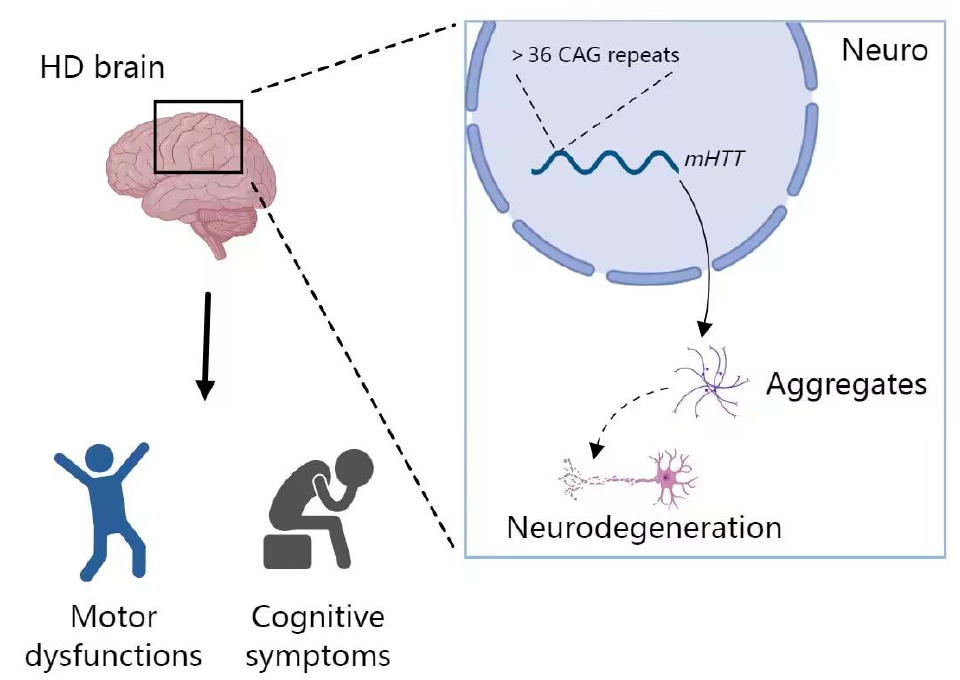
Figure 7. Schematic representation of HD pathogenesis.